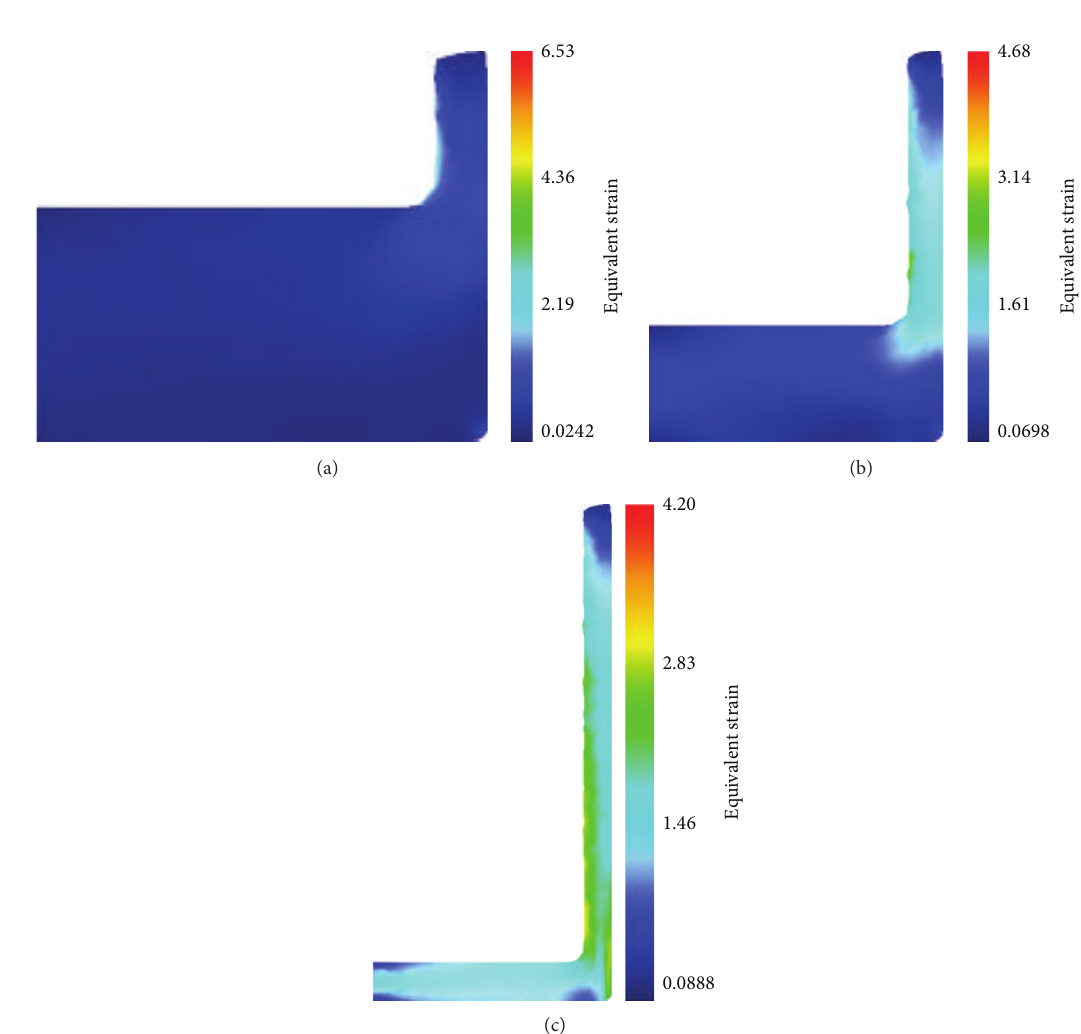
that the minimum values of deformation are P3 and P6 after